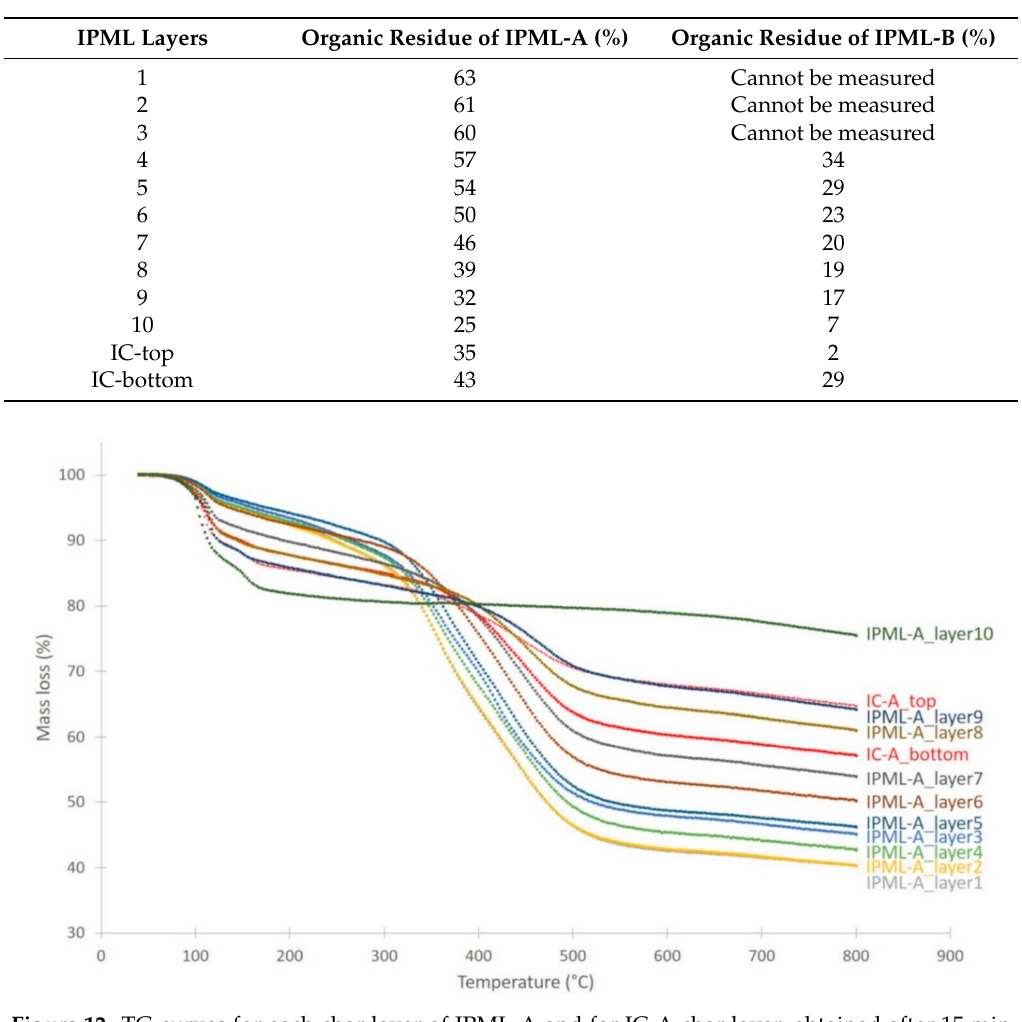
Figure 12. TG curves for each char layer of IPML-A and for IC-A char layer, obtained after 15 min burn-through test